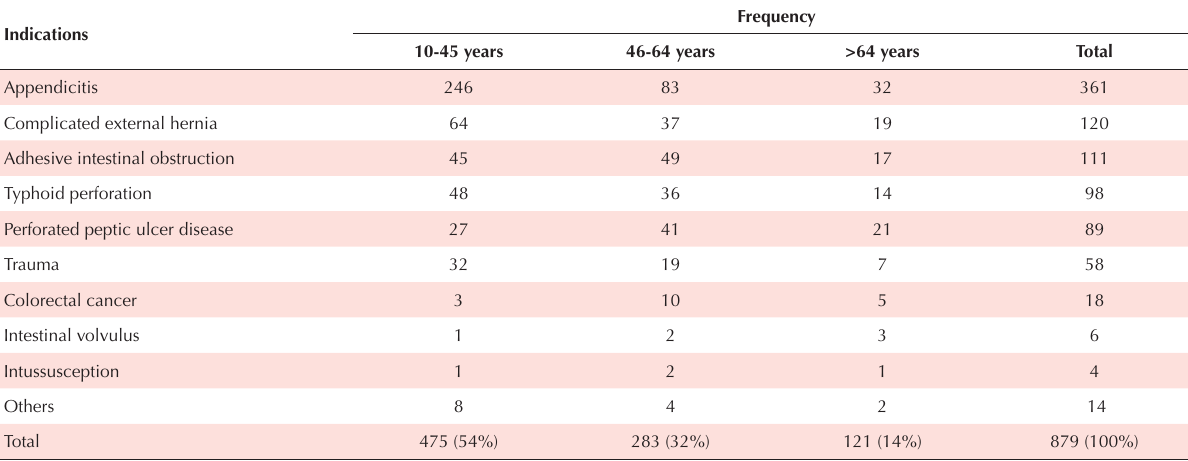
Table 1. Indications of laparotomy in the various age groups Indications